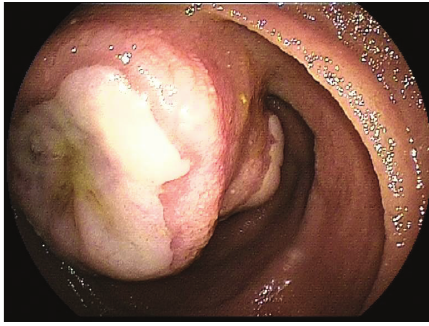
Figure 10: Gastrointestinal stromal tumour in the jejunum. Figure 11: Ileal carcinoid tumour.